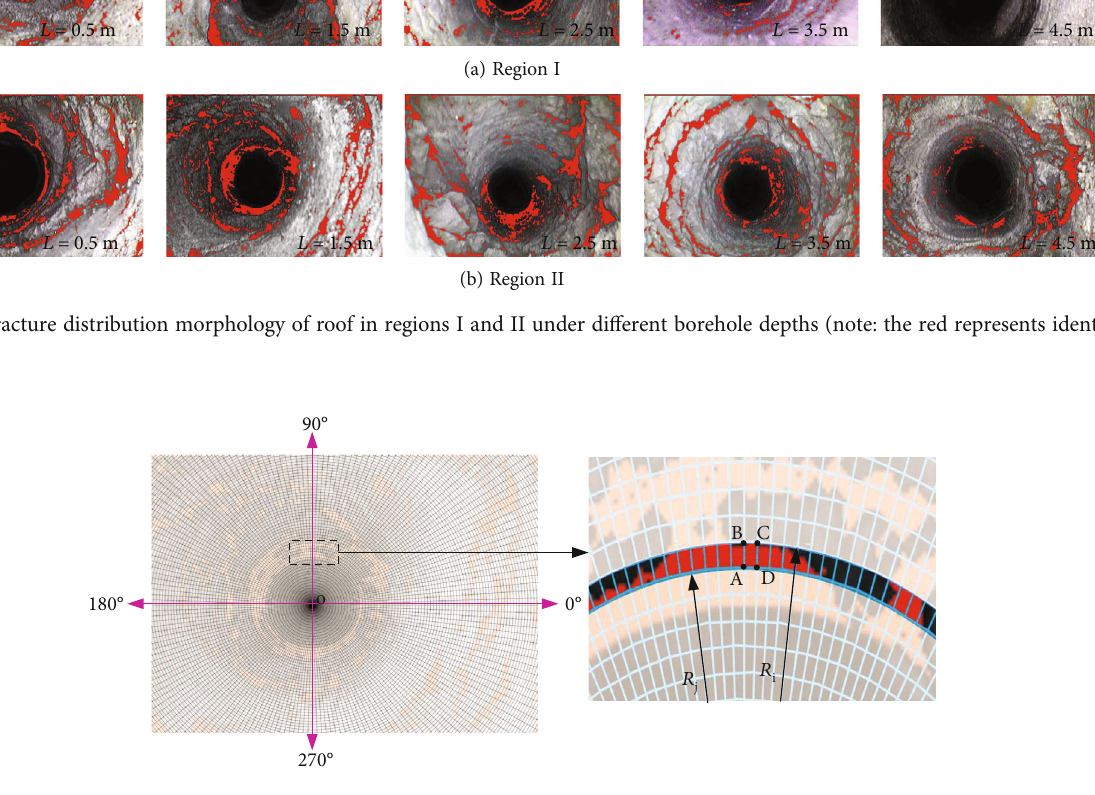
Figure 5: Schematic diagram of quantitative characterization principle of borehole fracture degree based on microelement method.